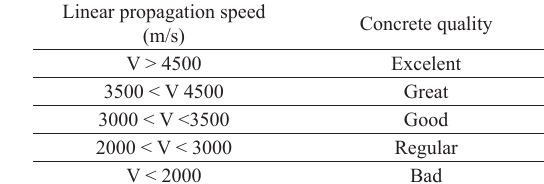
Table 6. Criterion used to evaluate the quality of the concrete 28